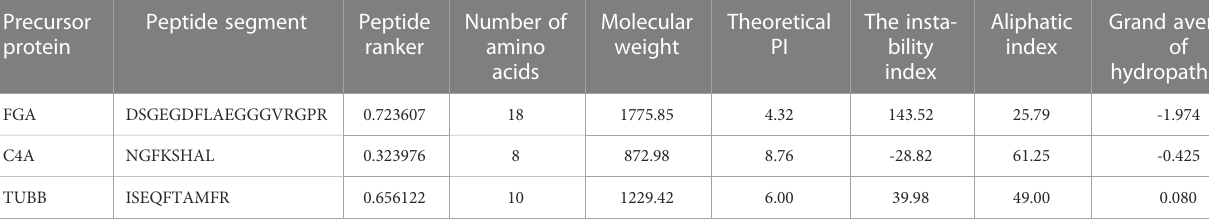
TABLE 3 The physical and chemical properties of 3 differentially